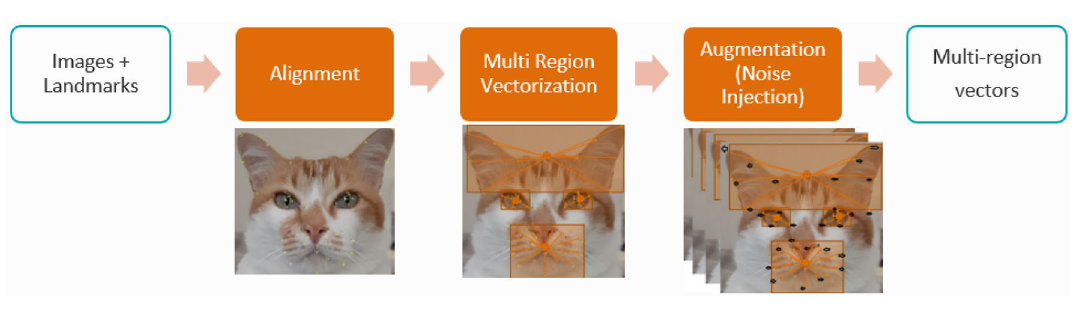
Figure 4. Preprocessing pipeline for model